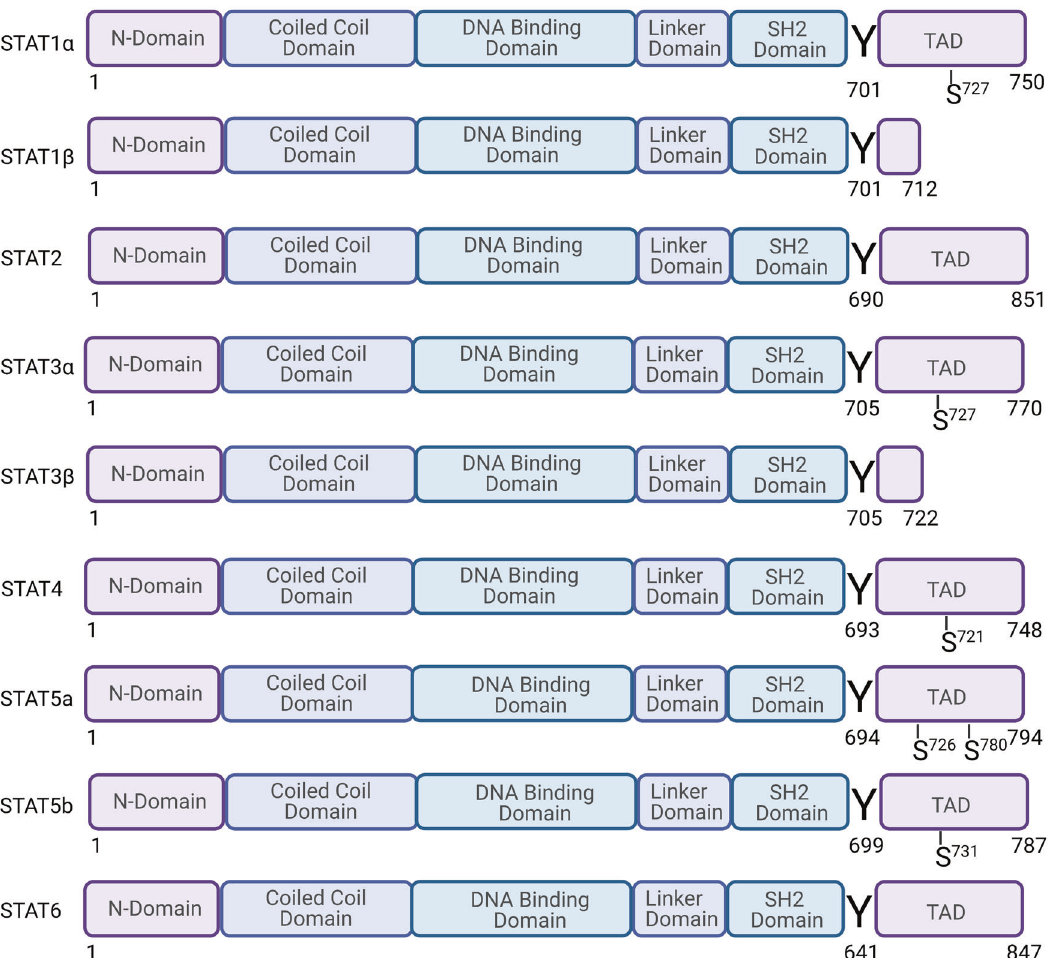
Fig. 2 Structure and phosphorylation sites of the STAT protein family. The signal transduction and activator of transcription (STAT) family have six members: STAT1 (STAT1 has two splicing isoforms, STAT1 α and STAT1 β ), STAT2, STAT3 (STAT3 has two splicing isoforms, STAT3 α and STAT3 β ), STAT4, STAT5a, STAT5b, and STAT6. STATs are composed of 750 – 900 amino acids. From the N-terminus to the C-terminus, the domains are the nitrogen-terminal domain, coiled-coil domain, DNA-binding domain, junction domain, SH2 domain, and transcription-activation structure. "Y" represents a tyrosine phosphorylation site, and "S" represents a serine phosphorylation site. Created with